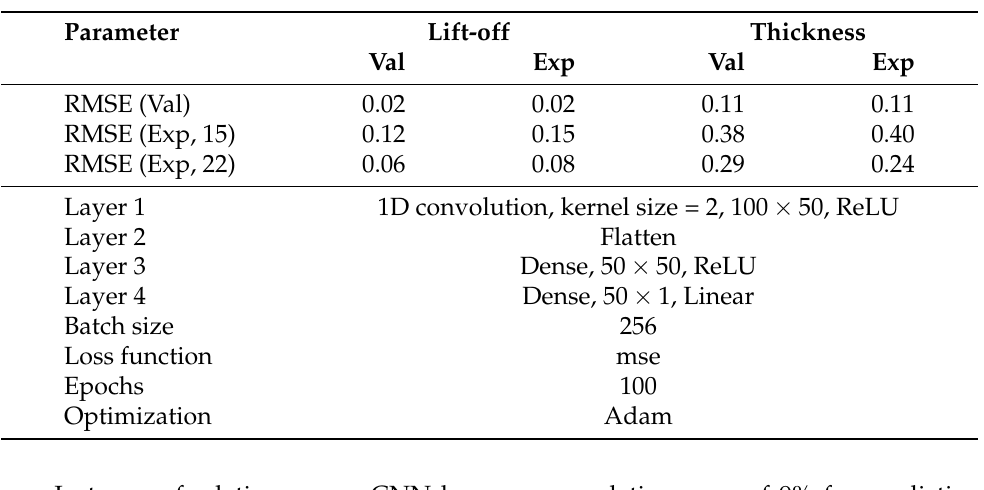
Table 5. Parameters of Convolutional Neural Network (CNN) regression models and corresponding RMSE values (Val model optimized using simulated validation set, Exp model optimized using the experimental